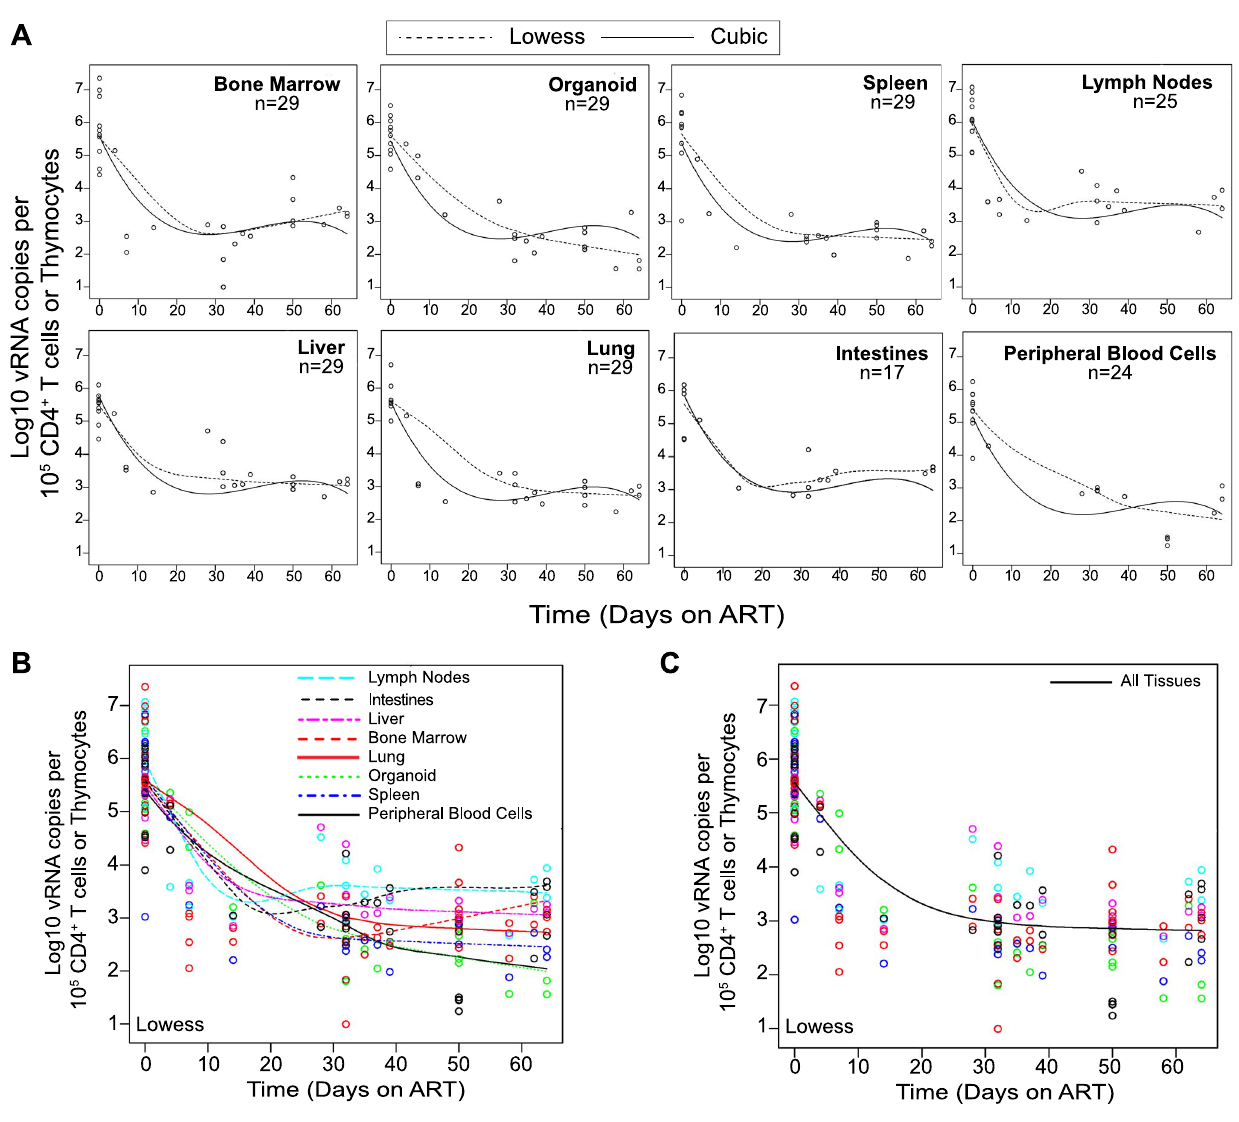
Figure 3. Viral RNA production during ART rapidly declines and then enters a plateau phase in all tissues. ( A ) Each data point indicates cell-associated vRNA levels (y-axis) and the days following ART initiation (x-axis) for a given BLT mouse in the indicated tissues. Both Lowess (dashed line) and a cubic (solid line) regression models were fit to the data for each tissue. ( B ) To facilitate comparative analyses between tissues, all of the Lowess regressions are graphed together. ( C ) To determine the overall impact of ART on systemic cell-associated vRNA levels, data from all of the tissues was used to generate a single Lowess curve.